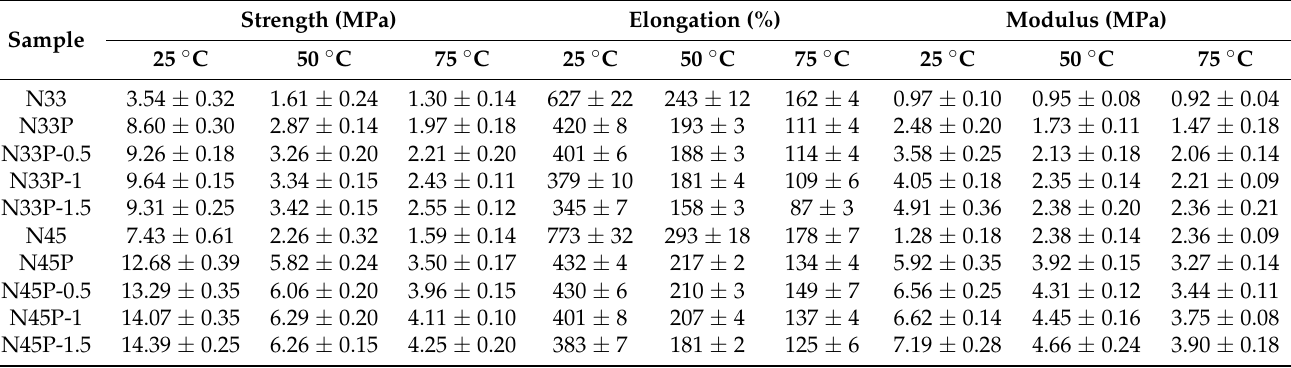
Figure 5. Microstructure of the blends and nanocomposites before and after etching in different magnifications. Table 4. Mechanical properties of the samples at 25, 50, and 75 ◦